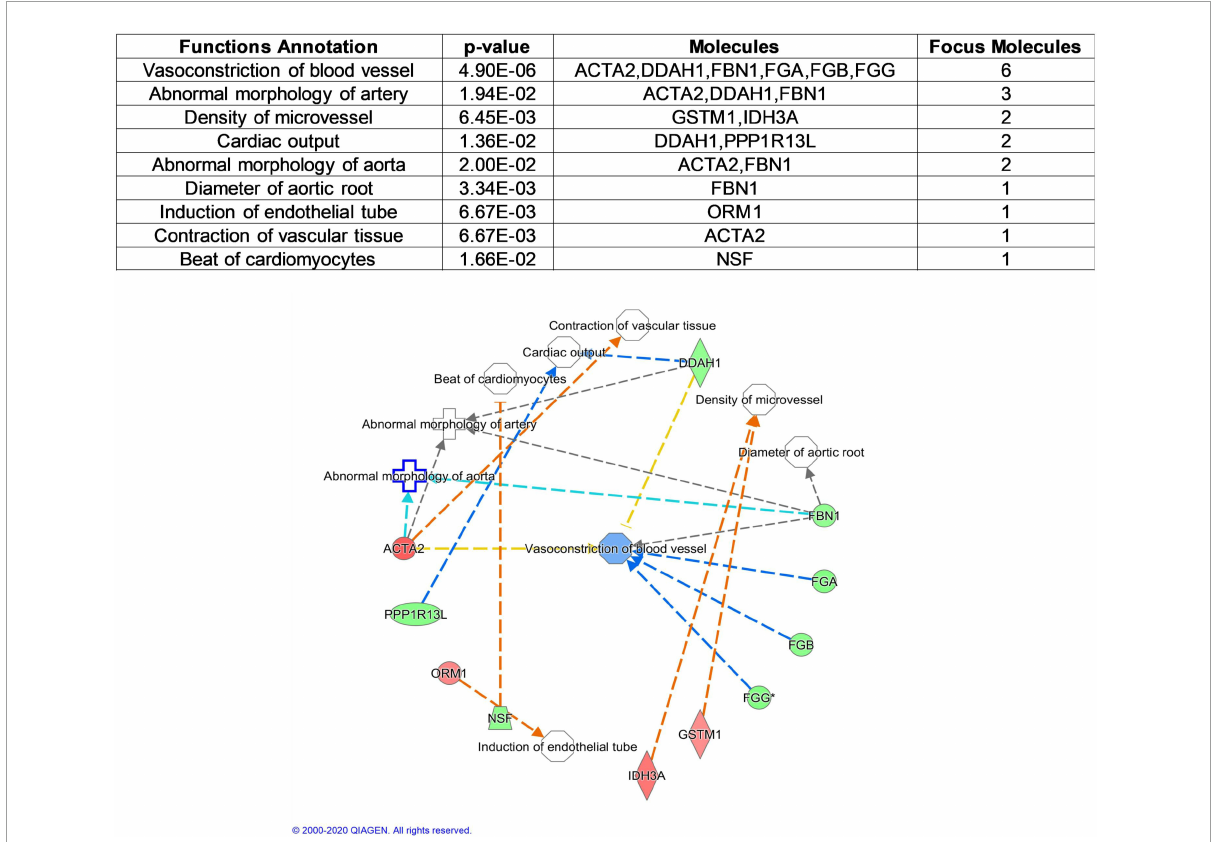
FIGURE4 Cardiovascular Functional analysis of differentially expressed proteins between normal and GDM umbilical vessels. For this cardiovascular function network, genes or gene products are represented as nodes , and the biological relationship between two nodes is represented as an edge . All edges are supported by at least one publication as stored in the Ingenuity Knowledge database. The intensity of the node color indicates the degree of up- (red) or down- (green)